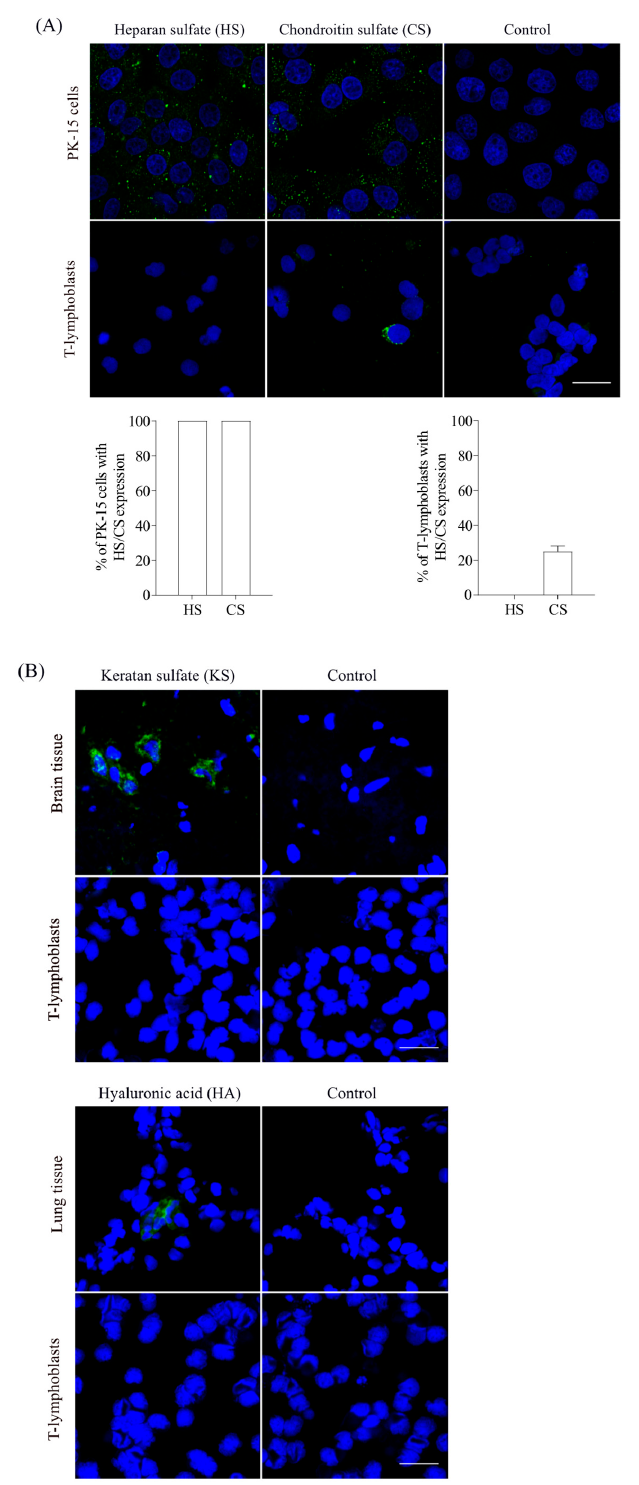
Figure 4. Expression of glycosaminoglycans (GAGs) on T-lymphoblasts. ( A ) Determination of the expression of heparan sulfate (HS) and chondroitin sulfate (CS) on PK-15 cells and T-lymphoblasts. Confocal images show PK-15 cells and T-lymphoblasts staining with specific antibodies against HS and CS. The percentage of PK15 cells / T-lymphoblasts with the expression of HS / CS were calculated and shown. Data represent means ± SD of triplicate assays. ( B ) Confocal images showing T-lymphoblasts and brain / lung tissues which were stained for the expression of keratan sulfate (KS) and hyaluronic acid (HA) using the specific monoclonal antibodies. Scale bar = 25 µ